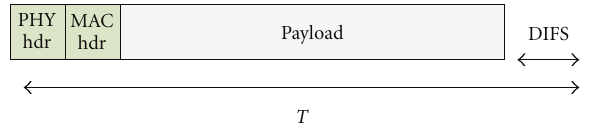
Figure 3: Structure of a transmission period of the broadcast packet.